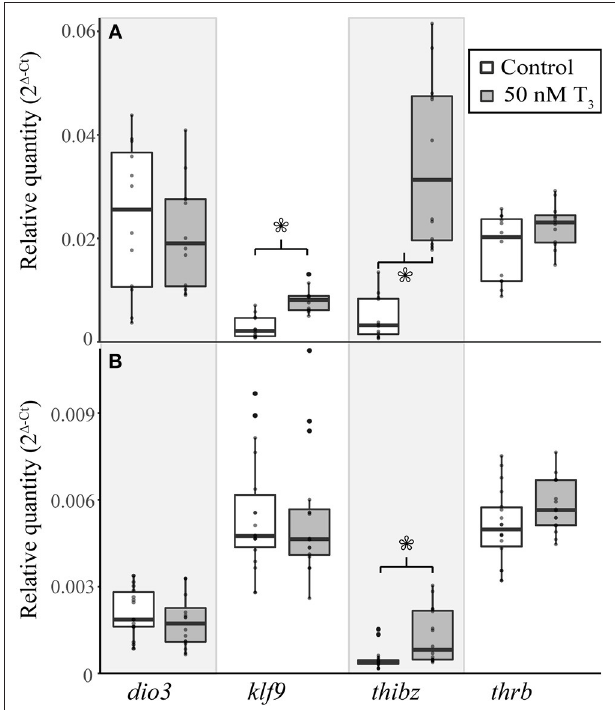
FIGURE 5 | Exogenous treatment with 50nM T 3 for 8h induces gene expression in the tail of E. coqui embryos at TS stage 9 (A) , but not in limbs at the same stage (B) . Boxes and whiskers depict the median and range of 12–16 individuals from two independent experiments. Asterisks indicate a significant change in expression (Student’s t -test, p < 0.05).